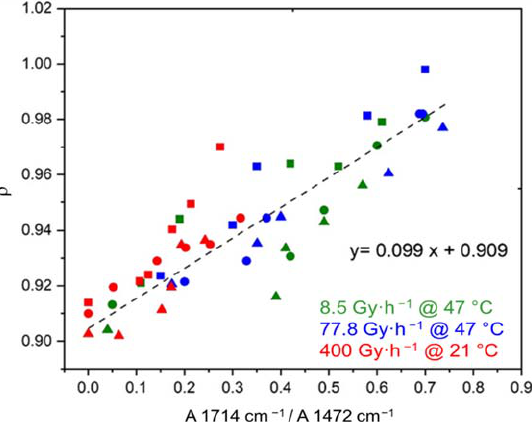
Figure 10. Density versus carboxylic acid index for the Si ‐ XLPE matrix filled with 0 phr ( □ ), 25 phr ( ∆ ), and 50 phr ( ) of ATH, during its radio-thermal exposure in air under 8.5 Gy · h − 1 at 47 ◦ C (green), under 77.8 Gy ∙ h − 1 at 47 °C (blue), and under 400 Gy ∙ h − 1 at 21 °C (red).